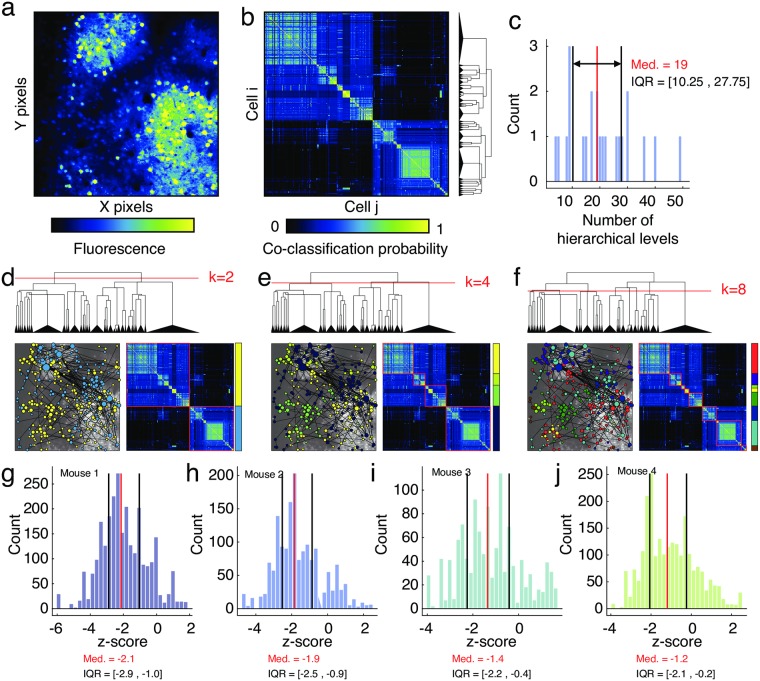
Detection of hierarchical modular structure.(a) Mean fluorescence of pixels, averaged over the full recording session. (b) Co-classification matrix generated using all statistically significant hierarchical levels. The dendrogram to the right depicts module splits. (c) The number of hierarchical levels aggregating data from all mice and all recording sessions. Panels (d), (e), and (f) depict module assignments at different levels of the hierarchy. The network diagrams shown in these panels are identical to one another and represent binarized matrices obtained by thresholding the jitter-adjusted correlation matrix of fluorescence traces between pairs of cells. Panels (g), (h), (i), and (j) depict distributions of z-scored mean intra-module Euclidean distance for each module and for each mouse. Panels (b), (d), (e), and (f) depict representative results from mouse 1. Here, the acronyms “IQR” and “Med.” represent interquartile range and median, respectively. Note also that nodes in panels b and d-f are ordered according to their hierarchical community assignments.